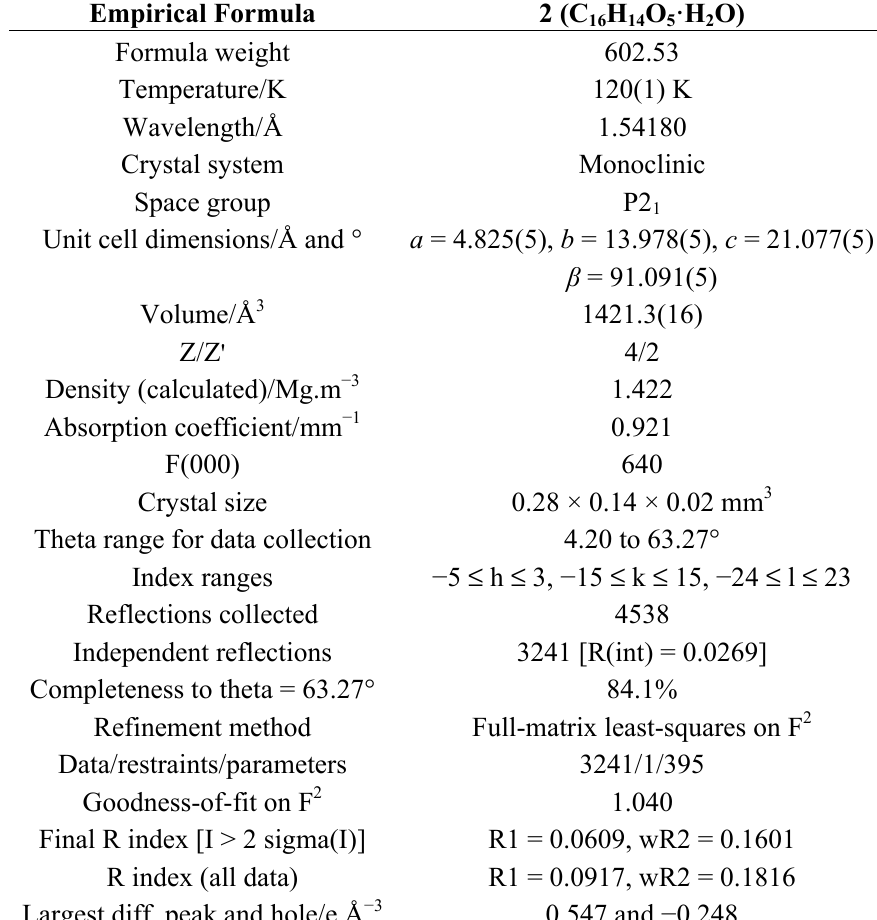
Table 1. Crystal data and structure refinement of